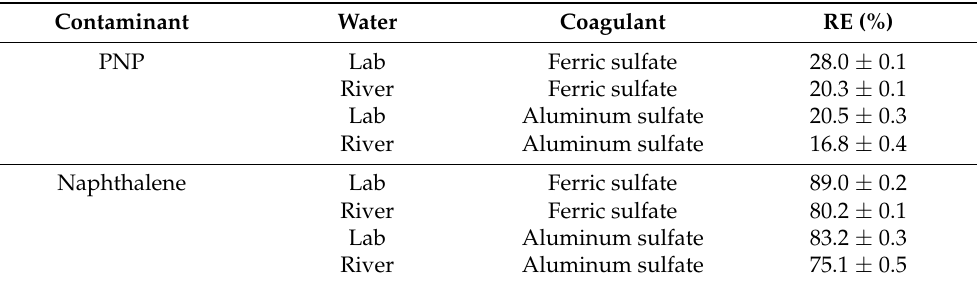
Table 4. Naphthalene and PNP removal efficiency (RE) with ferric and aluminum sulfate in